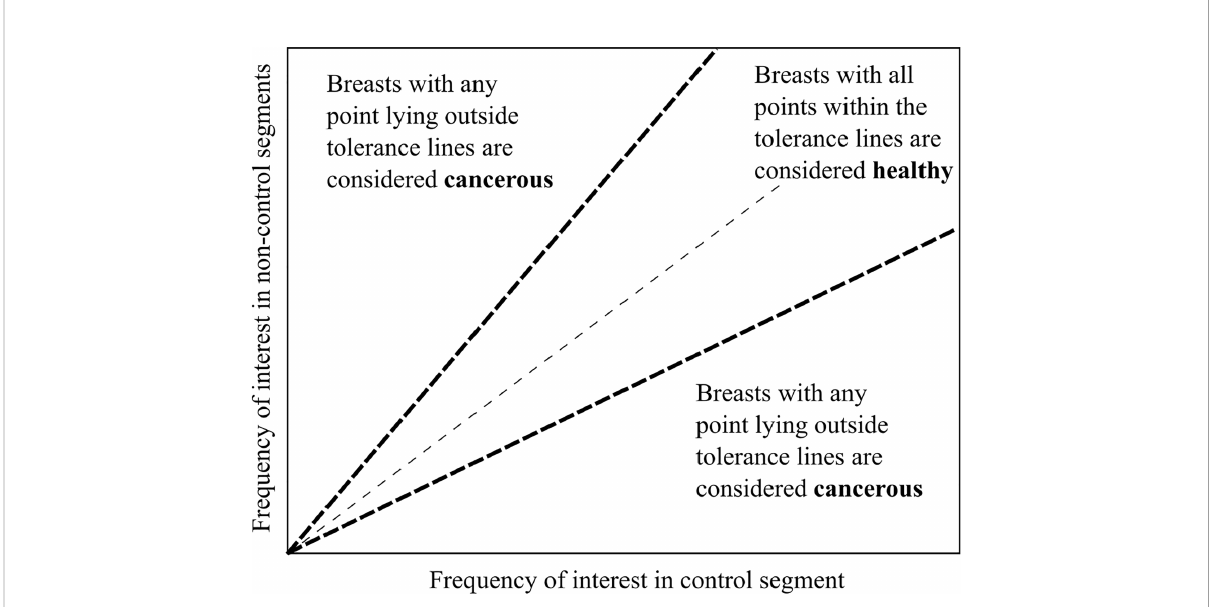
FIGURE 3 Tumor acceptance criteria showing simple diagnostic